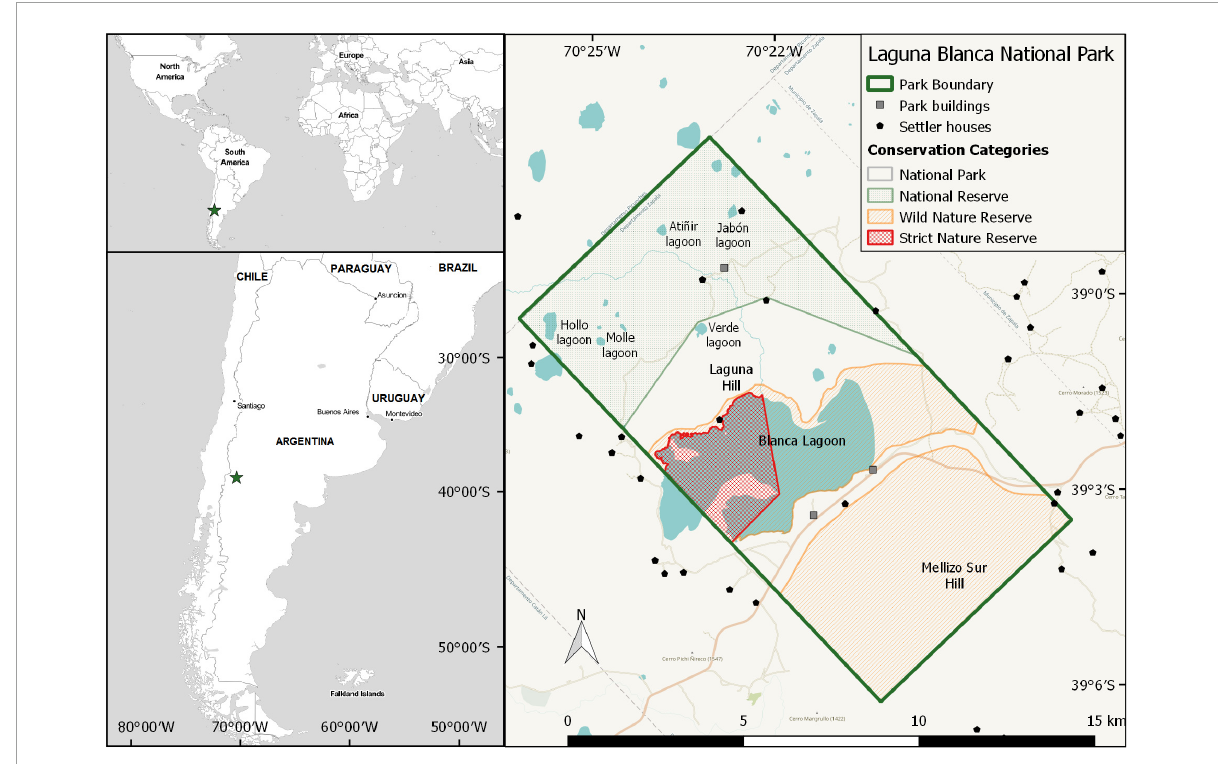
FIGURE1 Location of the Laguna Blanca National park and settlements inside and outside of the park. The limits of the different management categories of the park were also showed (modified from LBNP management